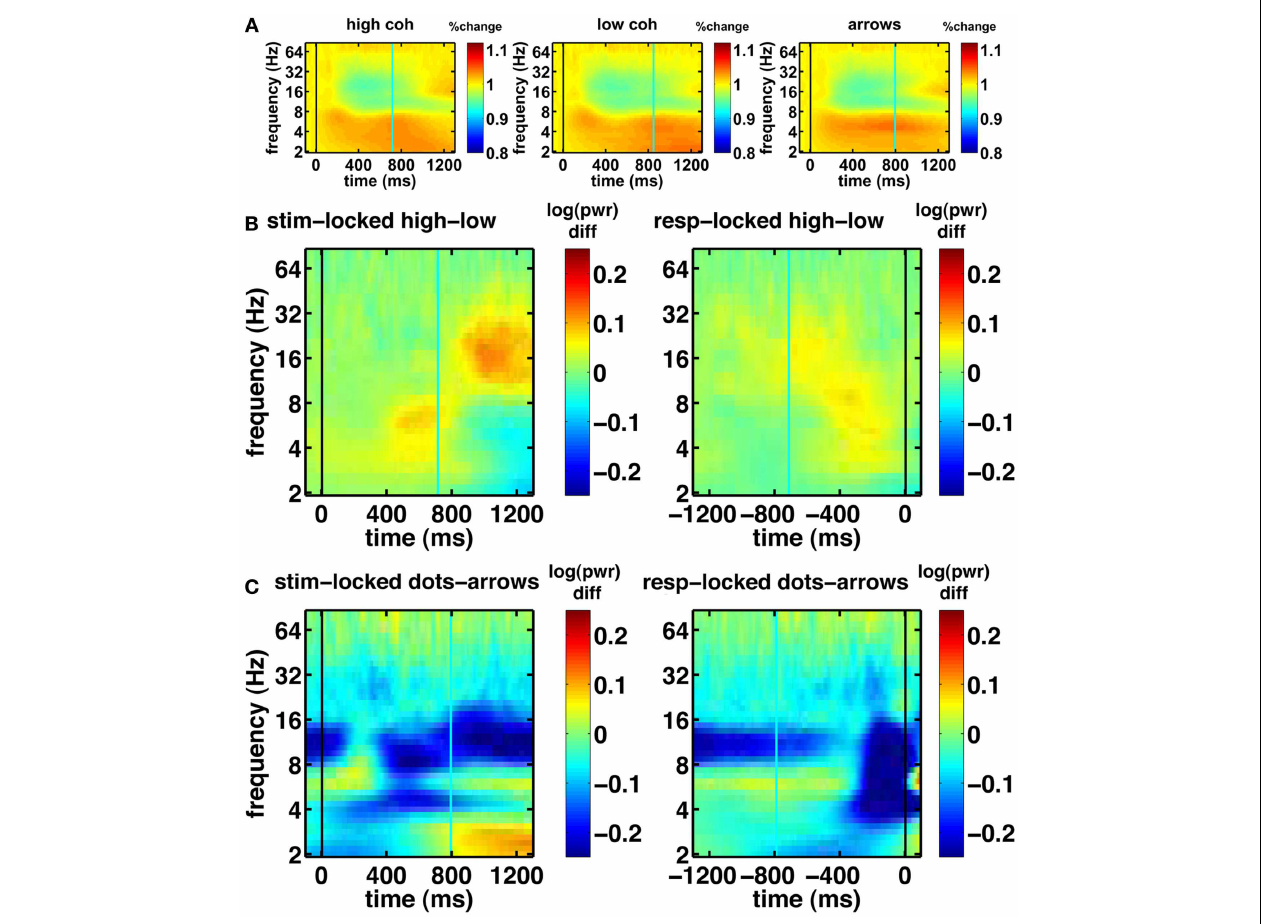
condition.There is a gradual decrease in oscillatory power over the course of the trial. (B) Difference spectrograms comparing low- and high-coherence conditions. Left column: stimulus-locked. Right column: response-locked. (C) Difference spectrograms indicating the contrast between integration and non-integration conditions. Left column: stimulus-locked. Right column: